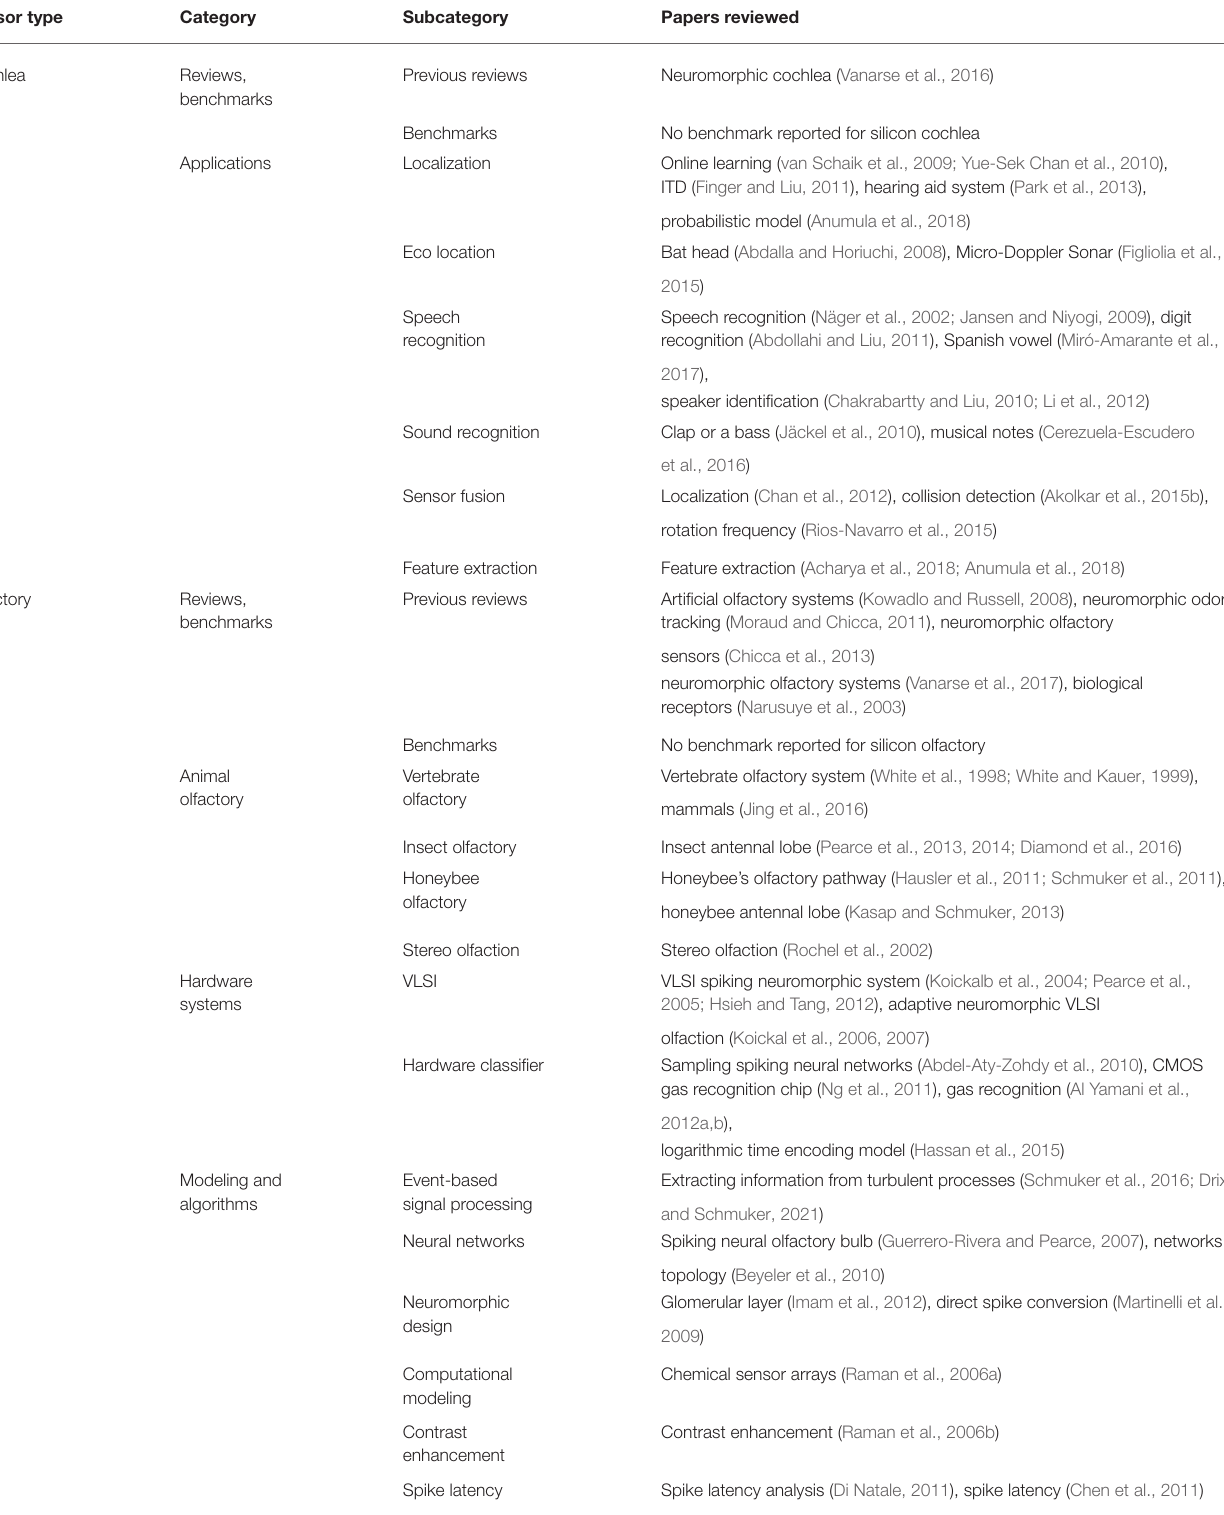
TABLE 2 | The paper